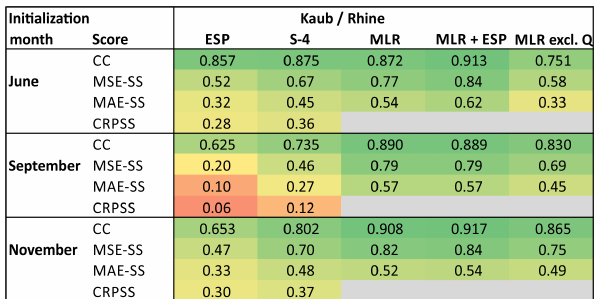
Figure 11. Comparison of forecast skill of the statistical forecast approach using ESP results as additional predictor for June and September forecasts at station Kaub/Rhine (predictand lowest 7- day mean flow MoNM 7 Q of the current month, verification period